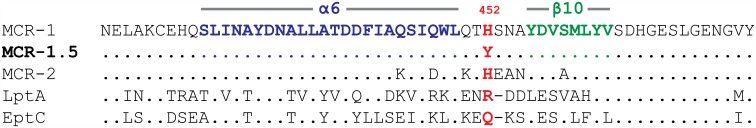
Alignment of the deduced amino acid sequence of MCR-1 and MCR-1.5 with other related phosphoethanolamine transferases.Position 452 (His in MCR-1; Tyr in MCR-1.5) is indicated in red between helix α6 (blue) and sheet β10 (green).